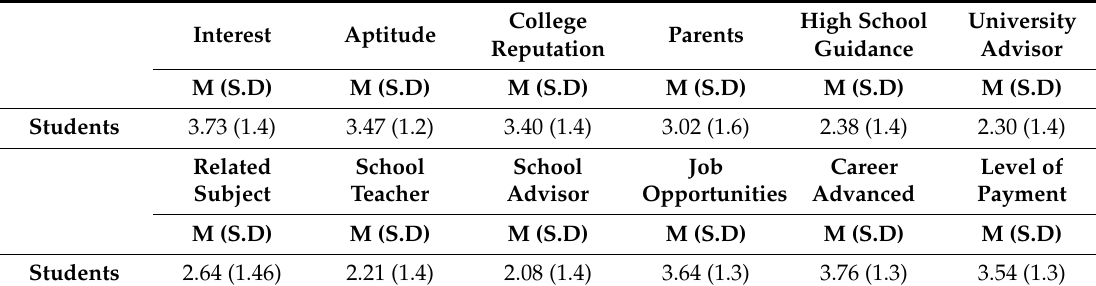
Table 2. Means and standard deviations for the factors that influence the choice of majors by students (N = 1725).